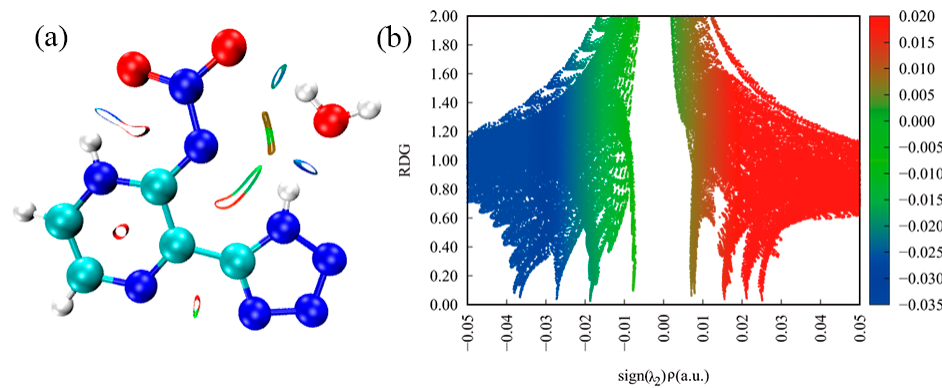
Figure 9. RDG map and NCI plot of gradient isosurface of Crystal b : ( a ) noncovalent interactions analyses; ( b ) scatter graph.